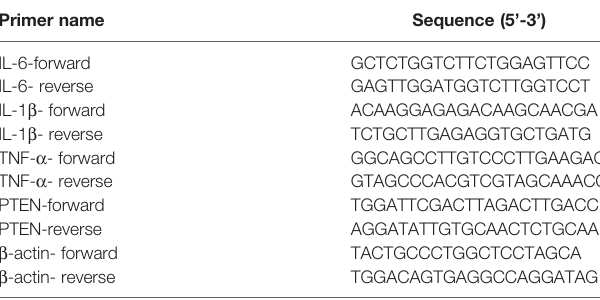
TABLE 1 | The sequences of primers for